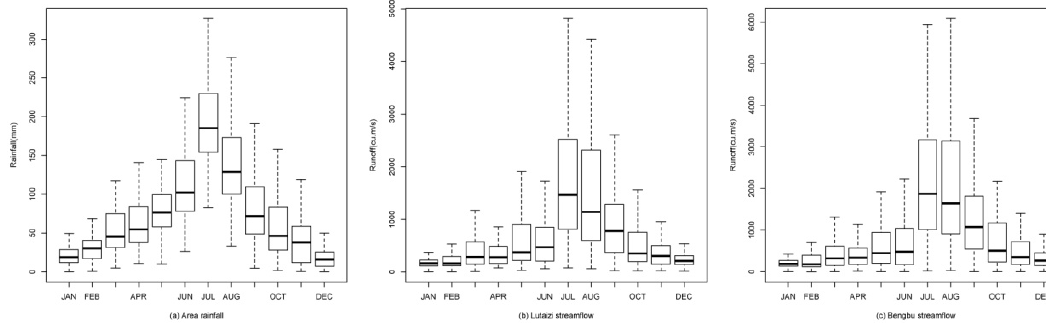
Fig. 2. Seasonality of area rainfall and streamflow in study region. Figure 2 : Seasonality of area rainfall and streamflow in study region. Table 1. Detail information for streamflow and rainfall station used in this